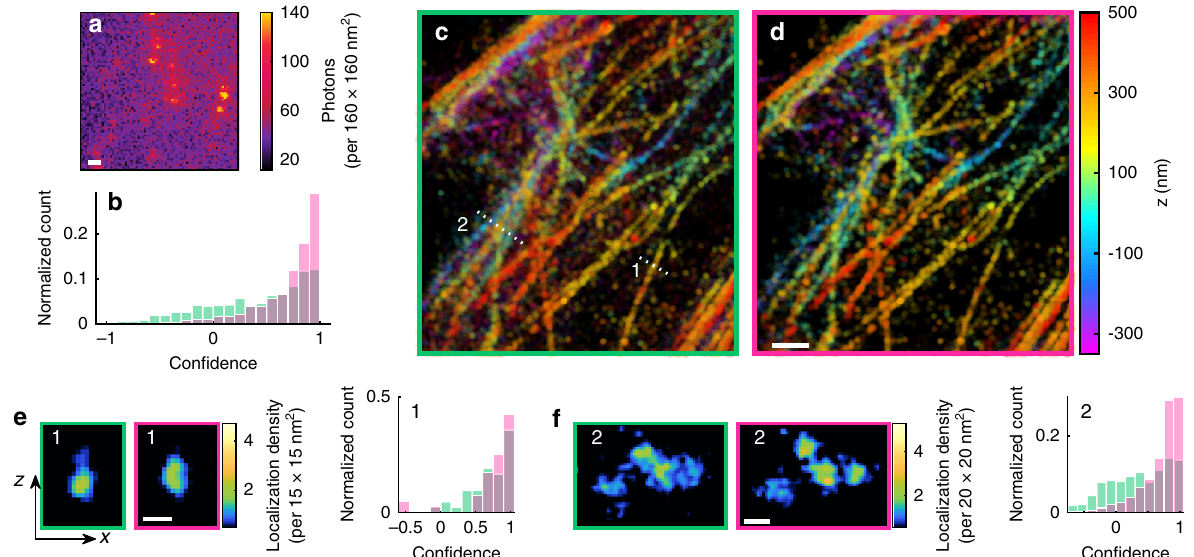
Fig. 3 Comparison of 3D SMLM algorithms on experimental images of Alexa Fluor 647-labeled microtubules. a Representative imaging frame of blinking SMs using the DHPSF. b Histogram of con fi dences of the Easy-DHPSF algorithm (green) and RoSE (red) corresponding to 500 randomly chosen frames from the 10,718-frame dataset. c 3D SMLM image of Easy-DHPSF localizations with apparent brightness greater than 1300 photons, color-coded as a function of z position. d Similar to ( c ), but for RoSE localizations. e Transverse ( xz ) images and WIF distributions of localizations along the dotted line (1) in ( c ) (window width = 492 nm) corresponding to Easy-DHPSF (green) and RoSE (red). f Similar to ( e ), but for the dotted line (2) in ( c ) (window width = 726 nm). Color bars: a photons detected per 160 × 160 nm 2 , c , d depth (nm), e localization density per 15 × 15 nm 2 , f localization density per 20 × 20 nm 2 . Scale bars: a , d 1 μ m, e 100 nm, and f 200